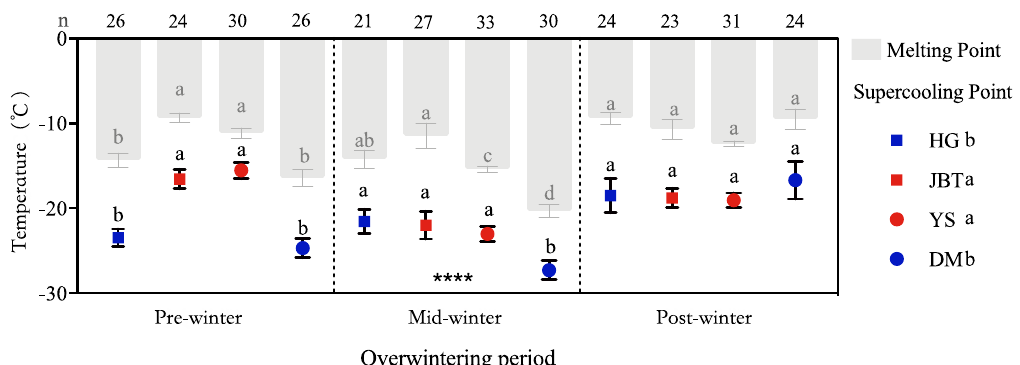
Figure 2. Supercooling points and melting points of S. noctilio larvae at different overwintering stages and sites. The bars are melting points (MPs) and the symbols are supercooling points (SCPs). Data points are means ± SEs and grey bars (one per column) are means of MPs with the 95% CI. Different letters in the same column indicate a significant difference with 95% confidence (Games–Howell test). **** means that the SCP of this group was tested to a difference of p < 0.0001 in Fisher’s LSD with others.